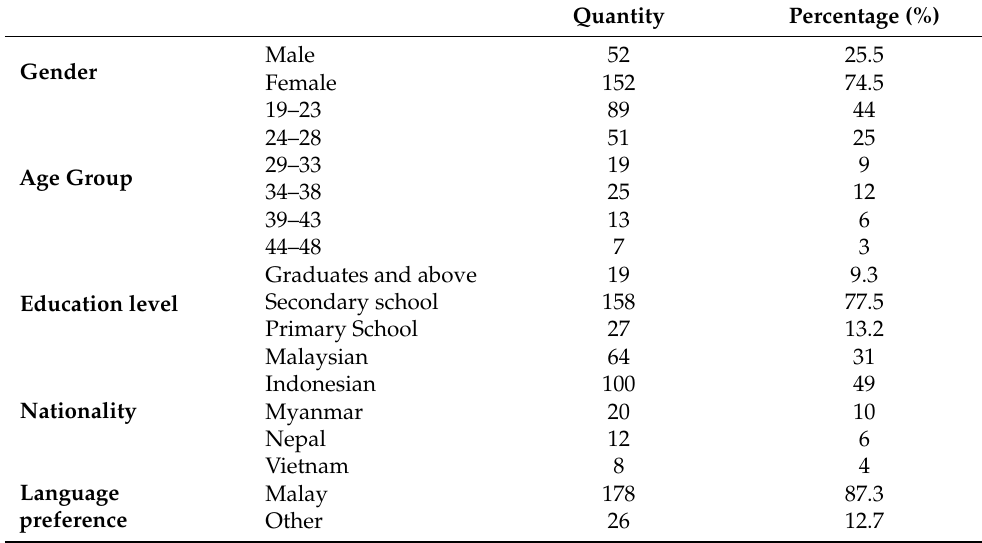
Table 2. Demographic characteristic variables of the study